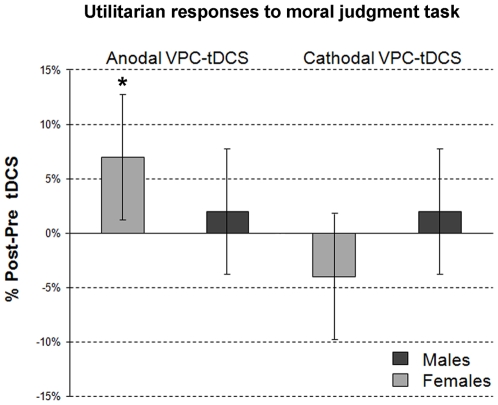
tDCS effects over the VPC on utilitarian responses to moral judgment task in males and females.Black columns: males. Gray columns: females. Y-axis: % (after-before) changes (0 = baseline) of the occurrence of utilitarian responses after tDCS. *: Wald chi-square test = 9.270; df = 2; p = .010. Error bars are the 95% confidence intervals (2 standard error of the mean). Note that whereas in males after VPC-tDCS utilitarian responses remained statistically unchanged, in females, after anodal VPC-tDCS utilitarian responses significantly increased.